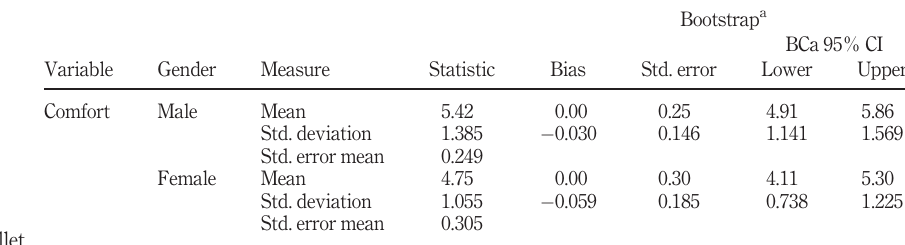
Table 6. Group statistics- comfort with eWallet